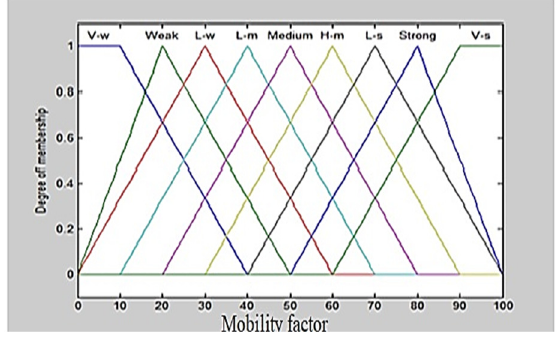
Fig. 7. Mobility factor.